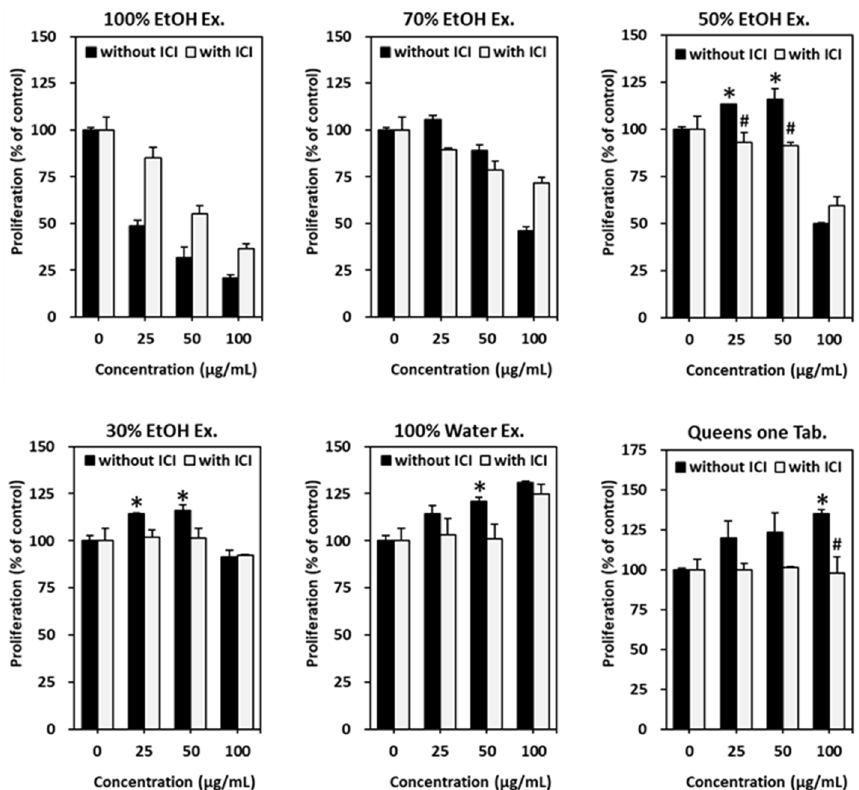
Figure 1. The estrogenic effect of V. rotundifolia fruits extracts on MCF-7 cell proliferation. Queens One Table was used as the positive control. The data are represented as the mean ± standard error mean (SEM). Statistical significance was evaluated and determined by a one-way analysis of variance (ANOVA), followed by the Tukey’s post-hoc test. Differences between means were considered statistically significant when p < 0.05. * p < 0.05 vs. untreated cells. # p < 0.05 vs. each group without ICI 182,780 treatment. 100% EtOH Ex.: Ethanol extract; 70% EtOH Ex.: 70% ethanol extract; 50% EtOH Ex.: 50% ethanol extract; 30% EtOH Ex.: 30% ethanol extract; Water Ex.: distilled water extract; ICI: ICI 182,780.